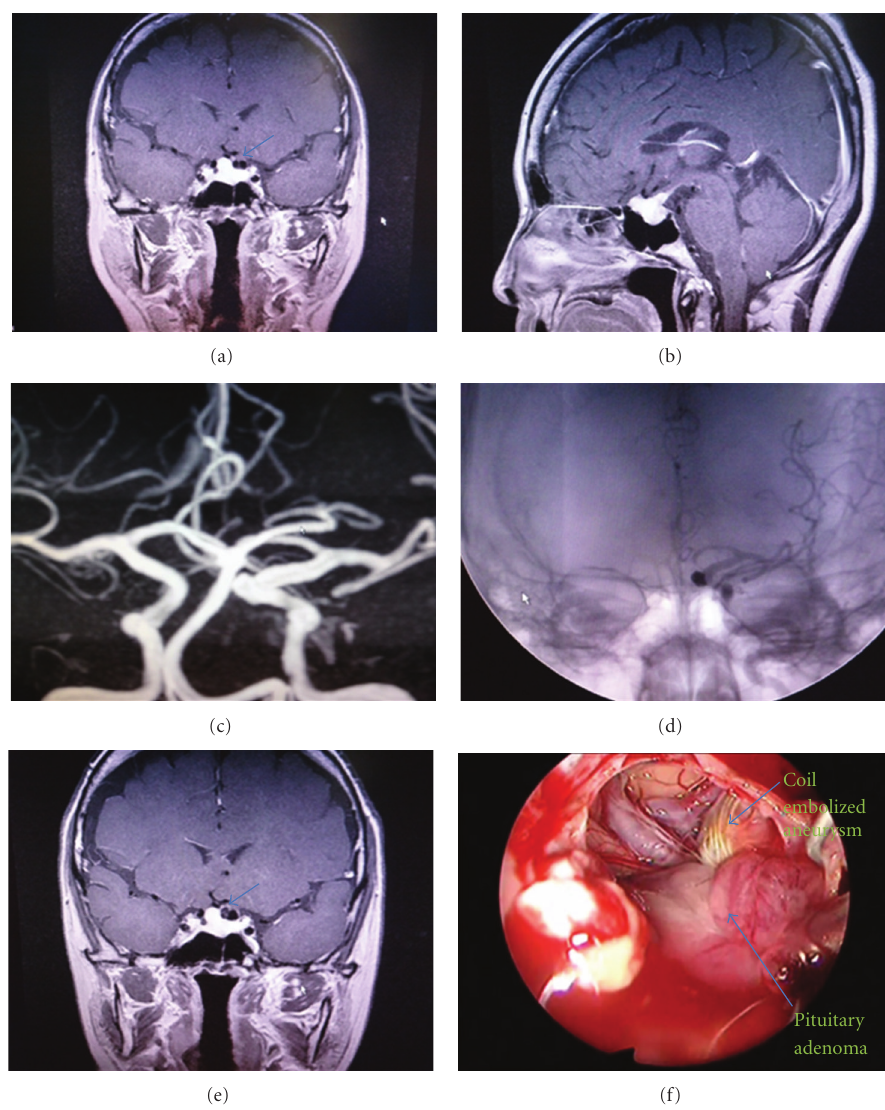
Figure 1: (a) Enhanced-MRI coronal image. (b) Enhanced-MRI sagittal image. An intrasellar mass lesion with suprasellar extension is suggestive of a pituitary adenoma with diameters of 17 × 16 × 11 mm. A flow void mass in the left supraclinoid internal carotid artery raised the suspicion of a cerebral aneurysm ((a) arrow). (c) MR angiography confirms a left supraclinoid internal carotid artery aneurysm (measuring approximately 6.0 mm in diameter). (d) Cerebral angiography. (e) Enhanced-MRI coronal image. The aneurysm is treated by endovascular coil placement ((e) arrow). (f) Intraoperative photograph. Pseudocapsule-based extracapsular resection of the pituitary tumor via a transnasal transsphenoidal endoscopic approach is performed. Coil-embolized aneurysm (arrow) is noted adjacent to pituitary adenoma